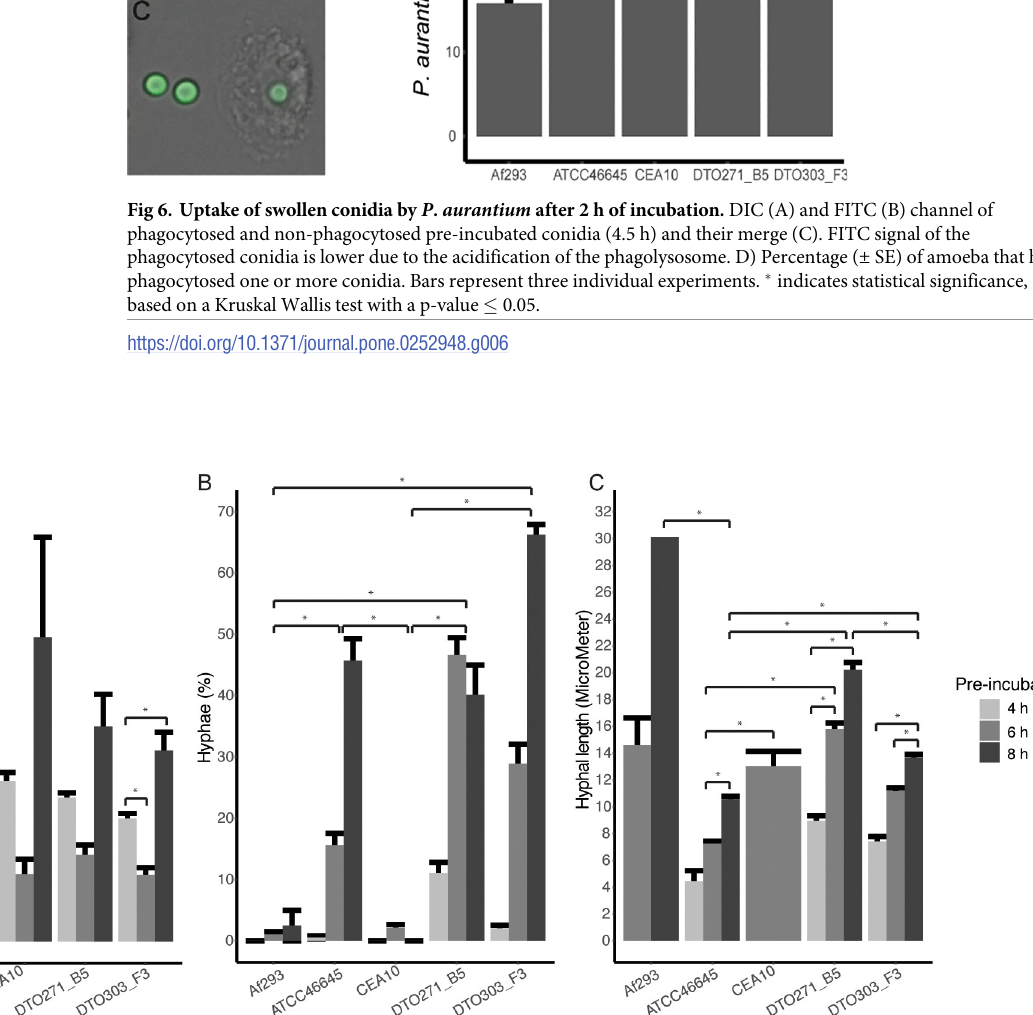
PLOS ONE | https://doi.org/10.1371/journal.pone.0252948 July 9,